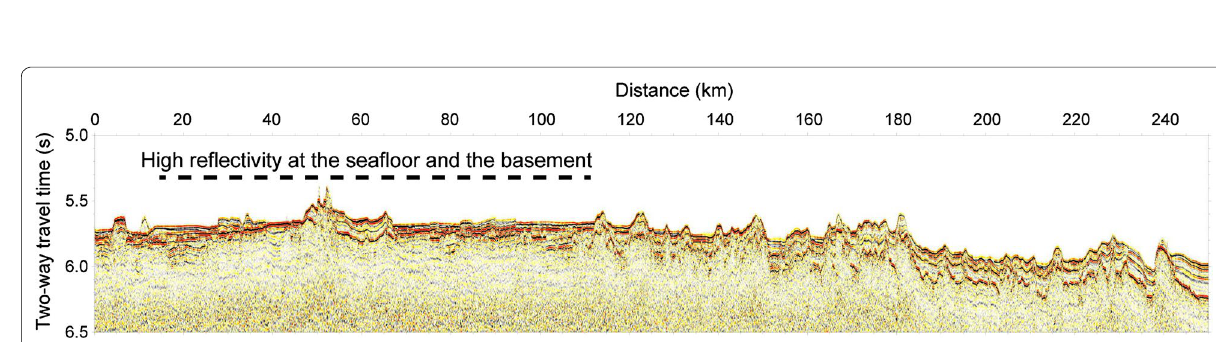
P ‑wave velocity structure of the crust and uppermost mantle On all OBS record sections, we observed refraction phases from oceanic layer 2 (P2), oceanic layer 3 (P3), and the uppermost mantle (Pn) as first arrivals (Figs. 6, 7). P2 and P3 were observed as first arrivals at offsets of up to about 30 km with an apparent velocity of 4.7–7.1 km/s. The apparent velocities of P3 are different between OBS1 section (6.5–6.6 km/s) and other (OBS2–5) section (7.0– 7.1 km/s) as shown in Fig. 8. One characteristic of the EW record section is that Pn appears at offsets of more than section, Pn appears at an offset of more than 350 km the NS lines, we identified Pn with an apparent velocity